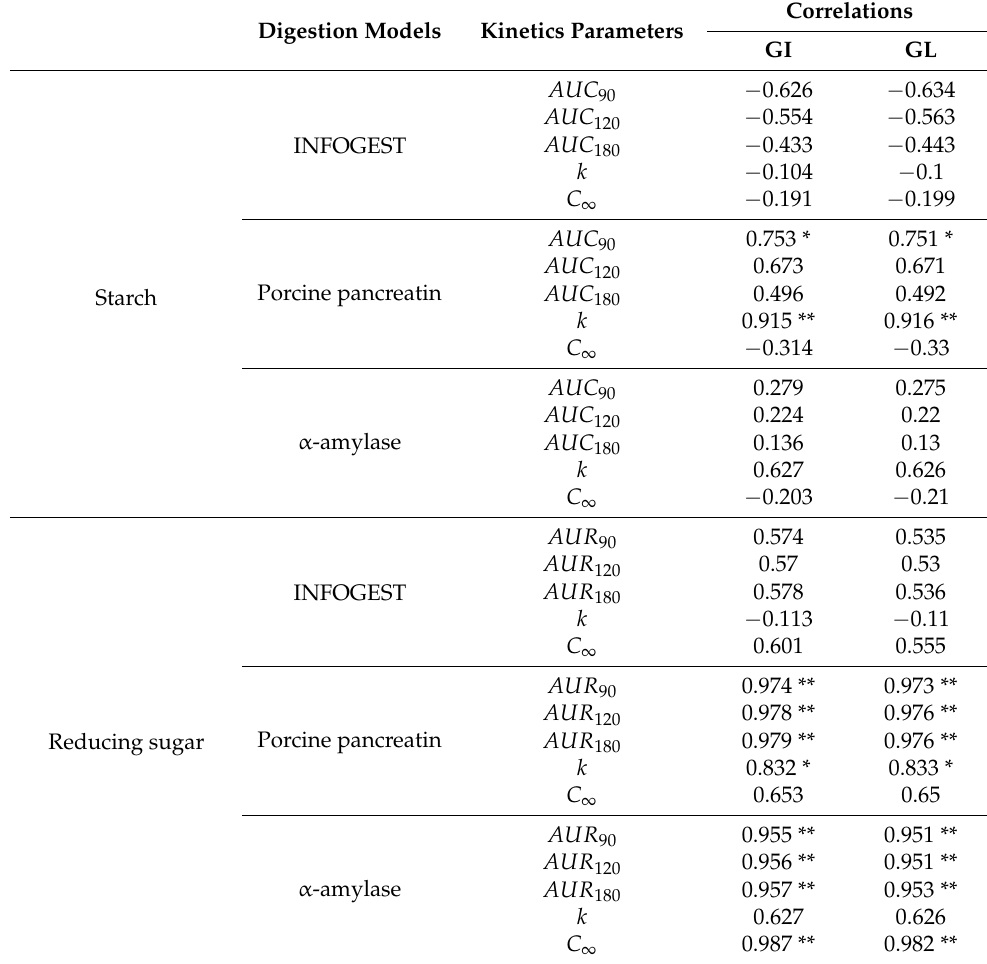
Table 4. Pearson’s correlations among the in vitro digestion parameters and clinical GI and the calculated GL values of all biscuits ( n = 8). Digestion